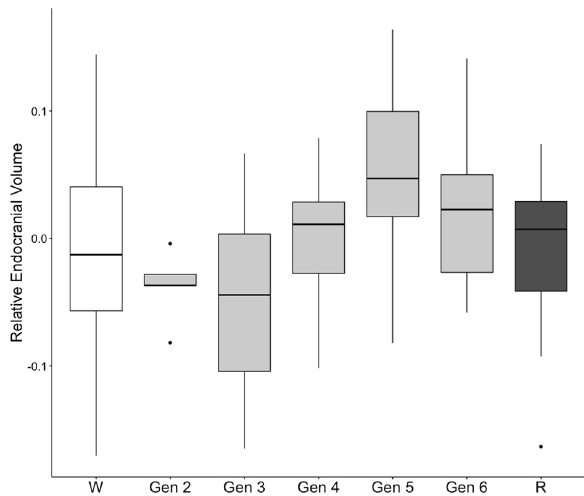
Figure 2. Relative endocranial volume (allometrically corrected residuals of endocranial volume relative to skull length) for wild (W), reintroduced (R), and captive generations rounded to whole numbers including captive generation 2 (Gen 2) 3 (Gen 3), 4 (Gen 4), 5 (Gen 5), and 6 (Gen 6). No clear statistical differences were observed between groups (F = 0.46; df = 2; p = 0.63), however captive wolves had greater variability. White represents wild, gray represents captive, and black represents reintroduced specimens. P -value significance: 0.01–0.05*, 0.001–0.01**,